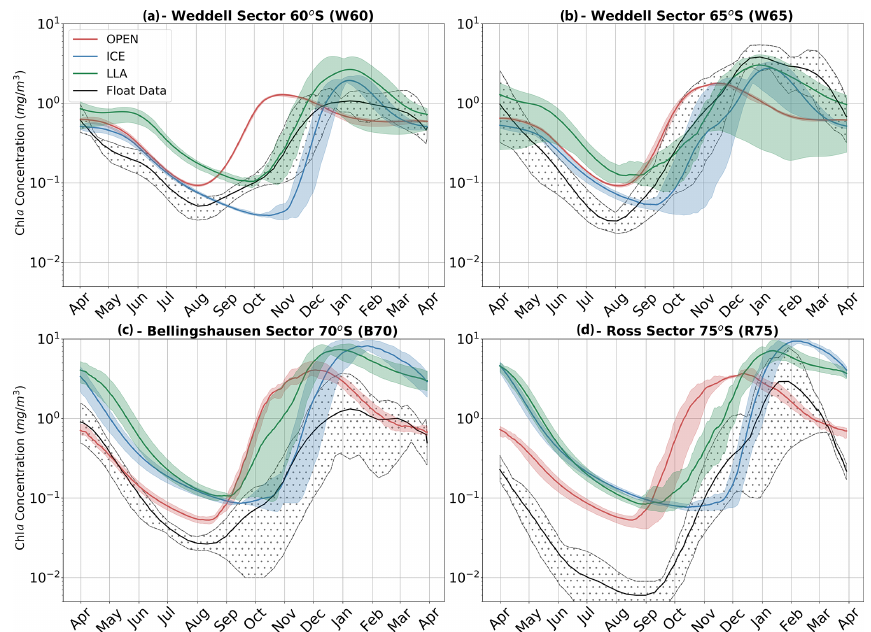
Figure 7. Time series of mean mixed layer Chl a for each of the four regions discussed in the text. In each panel, the observed values (black) are compared to three model experiments; runs with no sea ice are shown in red (OPEN), runs with ice are shown in blue (ICE) and runs with both ice and enhanced low light efficiency by phytoplankton are plotted in green (LLA). The shaded regions for each curve represent the spatial and temporal variability present in each data set as in Fig. 6. Note that the time series run from April to